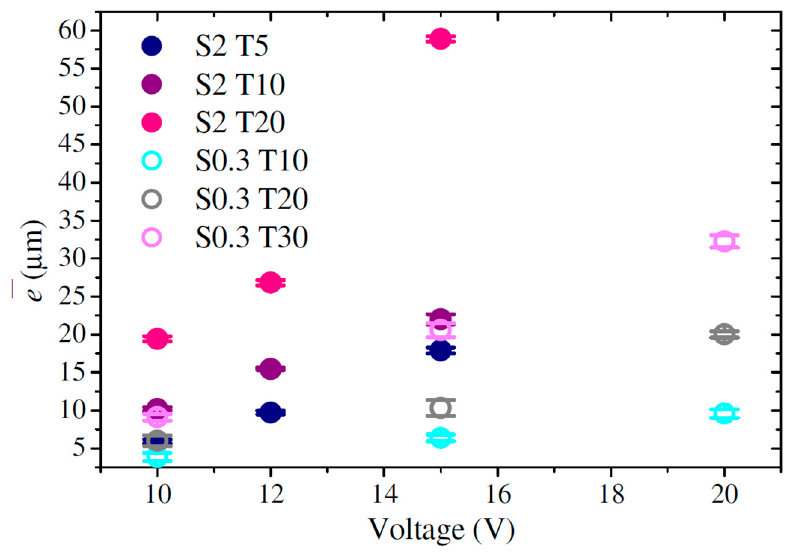
Figure 7. Variation of the average thickness of nanostructured aluminium oxide films anodized in sulphuric acid as a function of the concentration and temperature of the electrolyte and the volt- age.